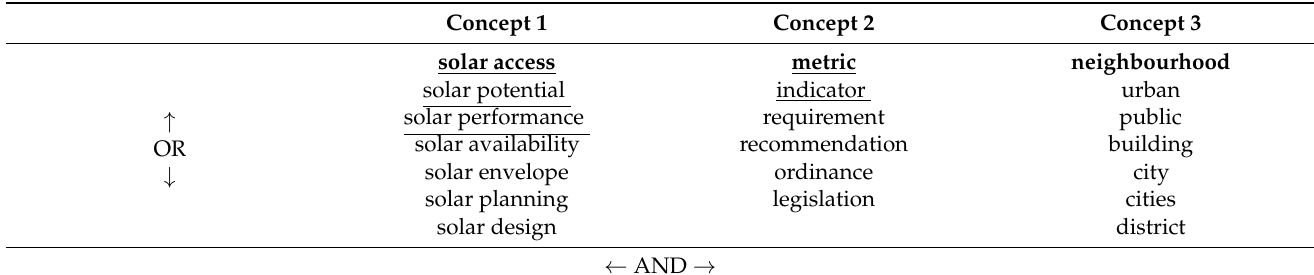
← AND → Keywords in bold capture the main distinct concepts, of which the rest of the keywords are synon ‐ ymous. Keywords that are underlined were used in initial scoping of a citation database.